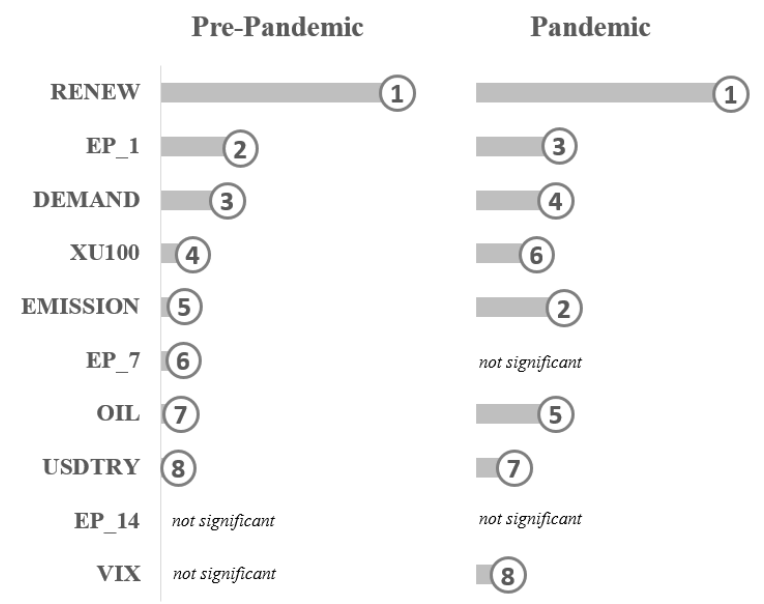
Figure 4. Variable importance analysis of the XGB algorithm. The most influencing factor affecting electricity prices is renewable electricity in both periods. The second and third most important factors, which are the 1-day lag of electricity price and electricity consumption in the pre-pandemic period, had almost equal